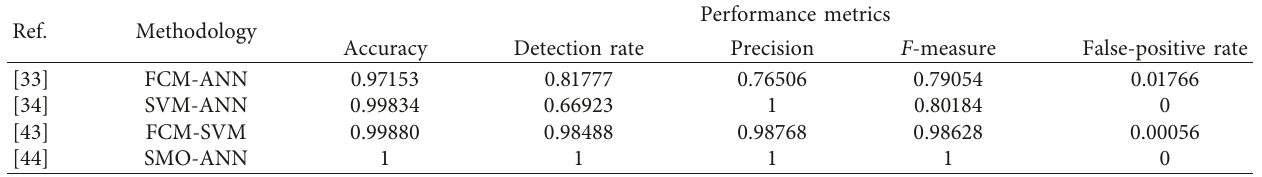
Table 12: Comparison of various methodologies based on different performance metrics for worm attack. Ref.